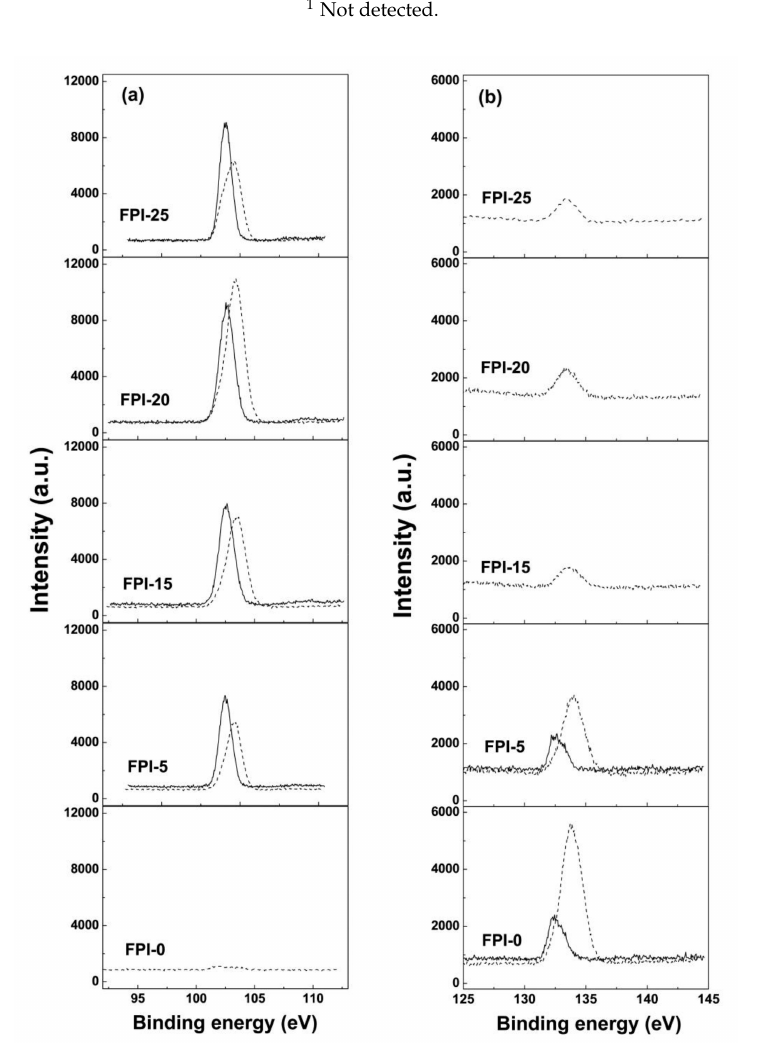
Figure 16. High-resolution XPS spectra of FPI-POSS films: ( a ) Si2p, ( b ) P2p before and after AO exposure with total AO fluence of 4.0 × 10 20 atom / cm 2 (the solid lines are unexposed films, the dashed lines are exposed